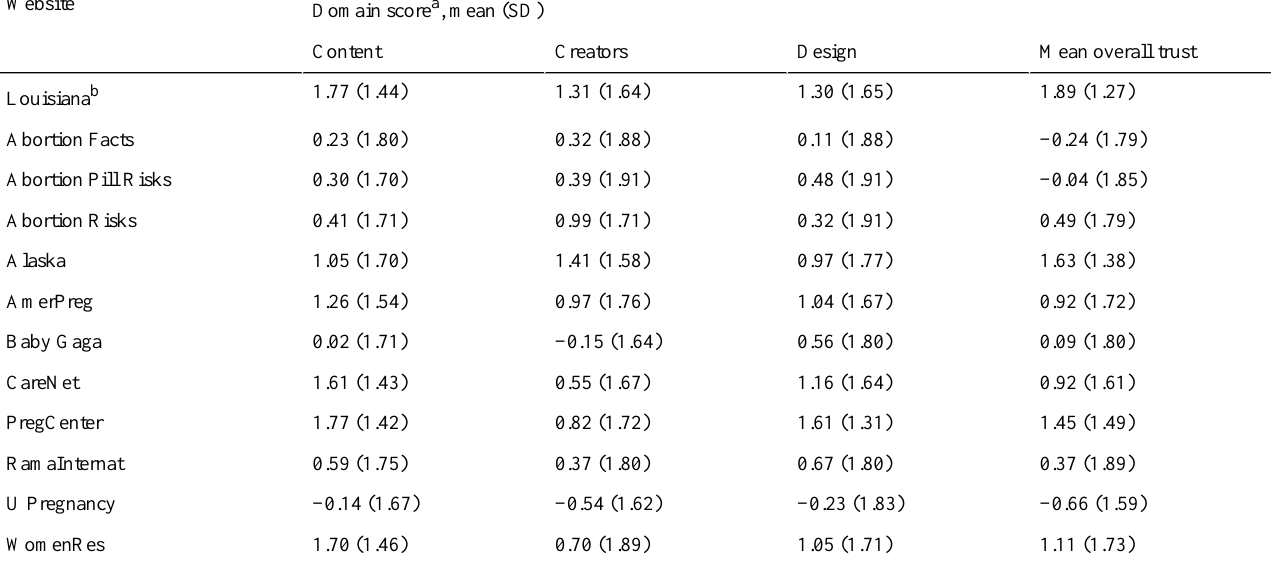
Domain score a , mean